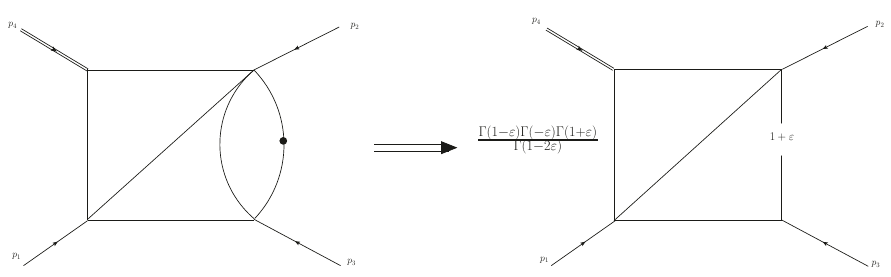
Figure 3 . Integrating out in F 32 the bubble subintegral we obtain a two-loop integral with 5 propagators, where the one related with the bubble subintegral has its power shifted by "